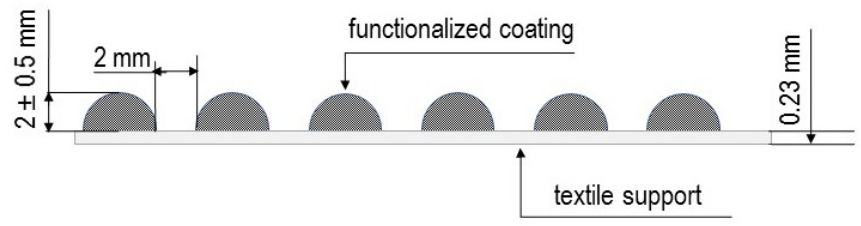
Figure 2. Schematic view of the samples.